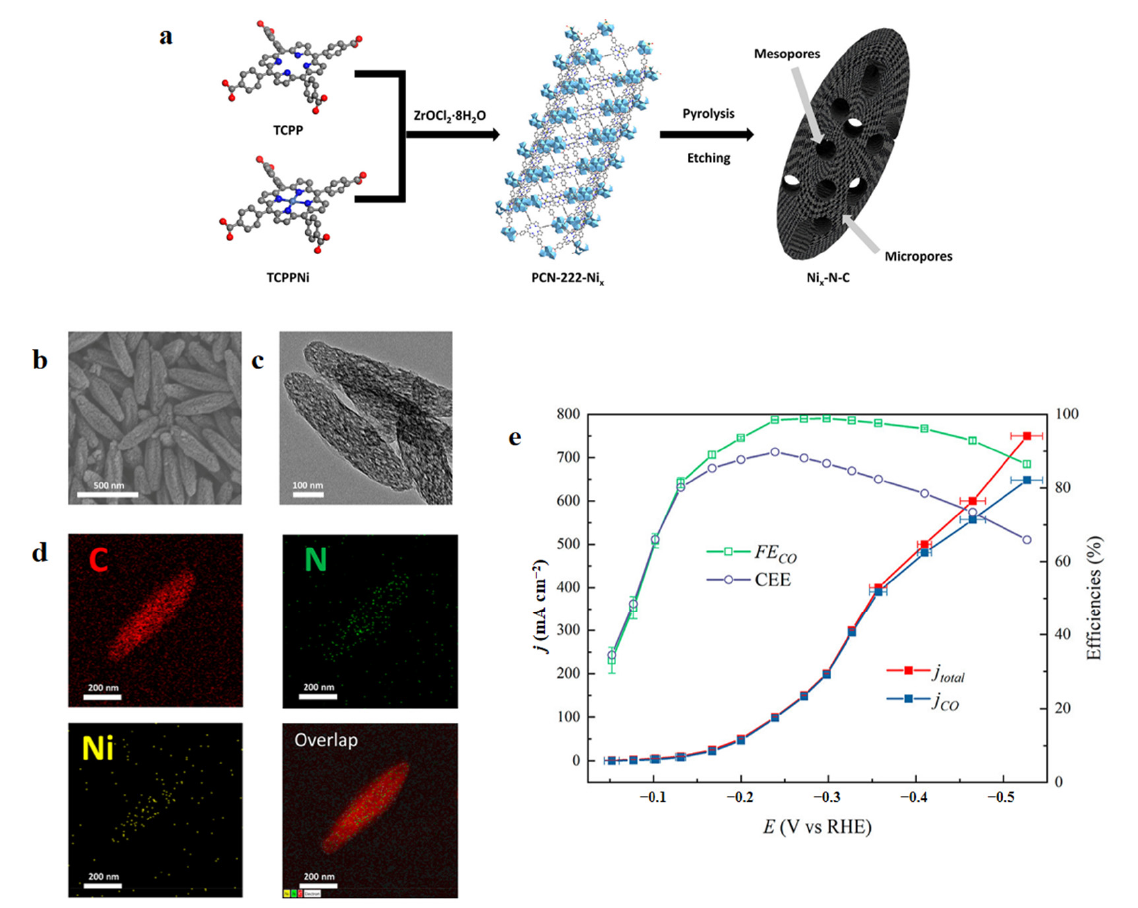
Figure 5. ( a ) Fabrication procedure for Ni x –N–C catalysts. SEM images of: ( b ) Ni 20 –N–C; ( c ) Ni 100 – N–C. ( d ) EDS mappings. ( e ) Electrocatalytic performance of Ni 20 –N–C in 6 M KOH. Reproduced with permission from Ref. [107]. Copyright 2020 American Chemical Society.